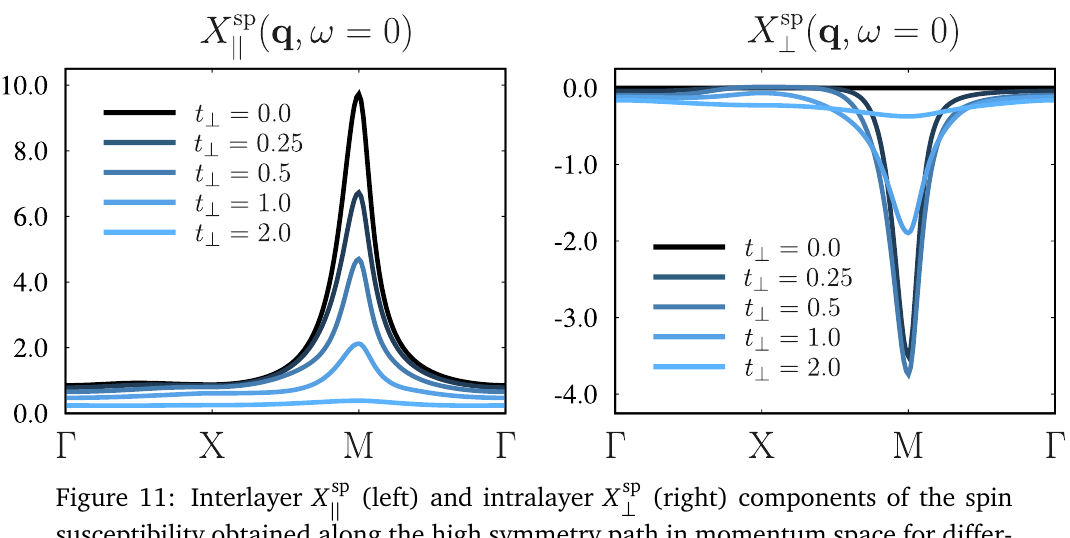
(left) and intralayer X sp (right) components of the spin Figure 11: Interlayer X sp ⊥ || susceptibility obtained along the high symmetry path in momentum space for differ- ent values of the interlayer hopping t ⊥ . Calculations are performed for the bilayer square lattice at t = 1, U = 4, and β =